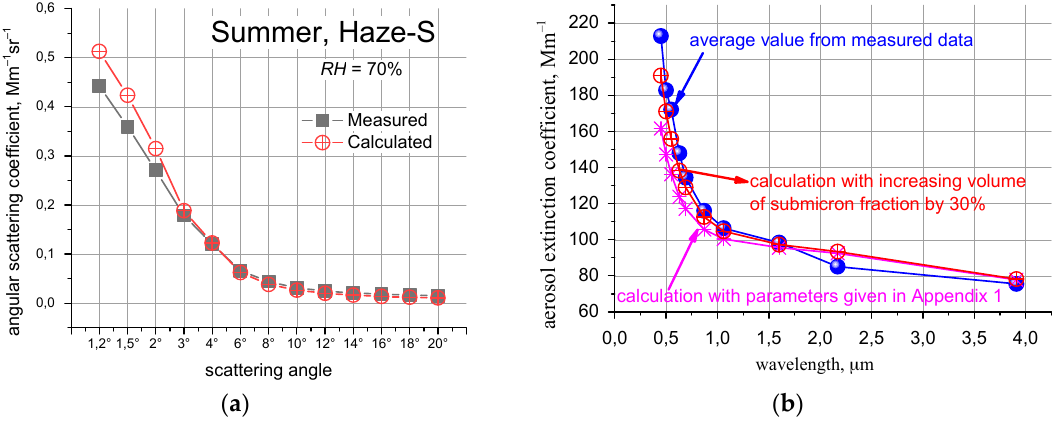
Figure 7. Comparison of measured and calculated values of angular scattering coefficient ( a ) and spectral behavior of the extinction coefficients in the visible wavelength range ( b ).